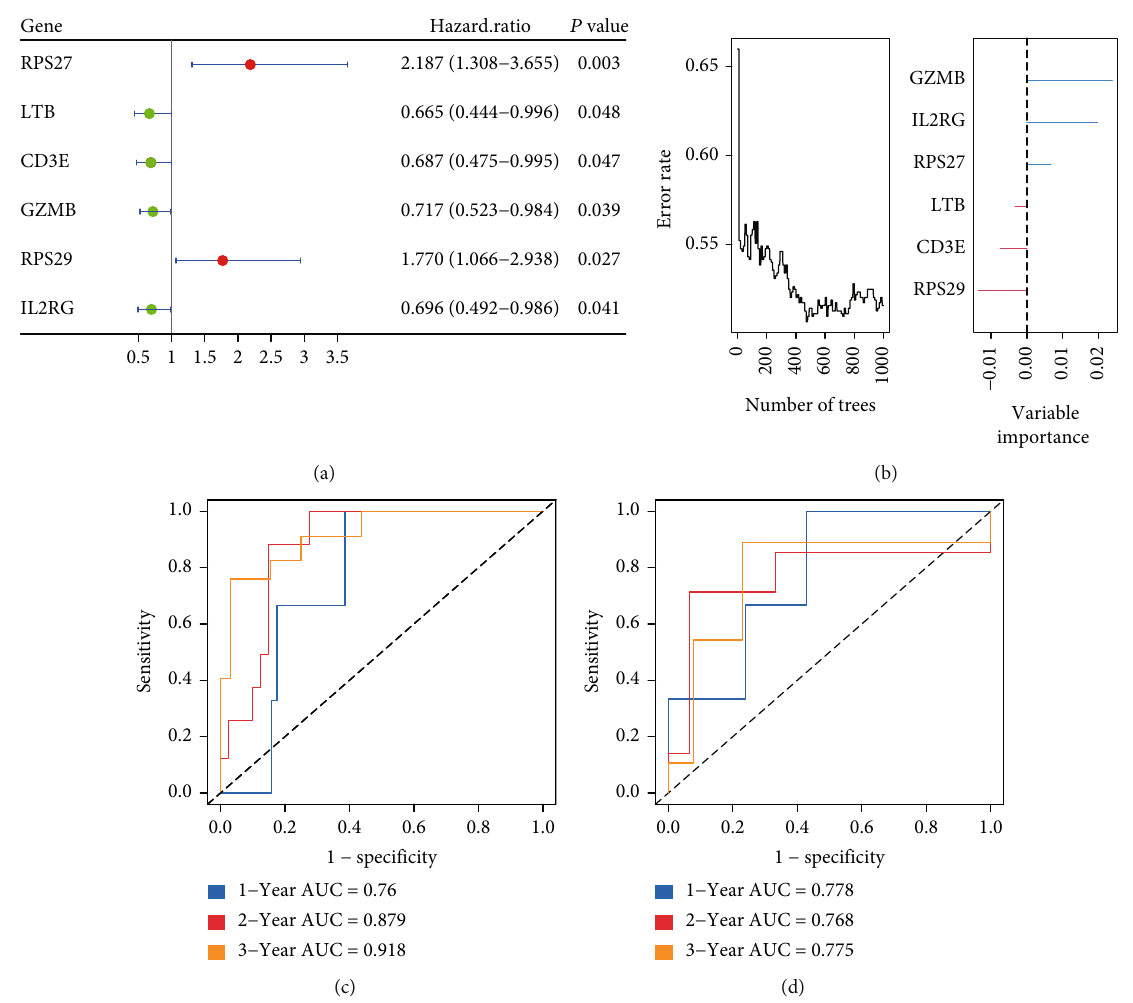
Figure 3: Construction of risk models. (a) Univariate regression analysis of CD8-DEGs. (b) Plot of the out of bag (OOB) prediction error rate for each tree constructed in the CD8-DEG model (left panel). Plot of variable importance in the CD8-DEG model (right panel). (c, d) ROC curves showed the predictive e ffi ciency of the CD8-DEG risk score for 1-, 3-, and 5-year survival in the training and validation